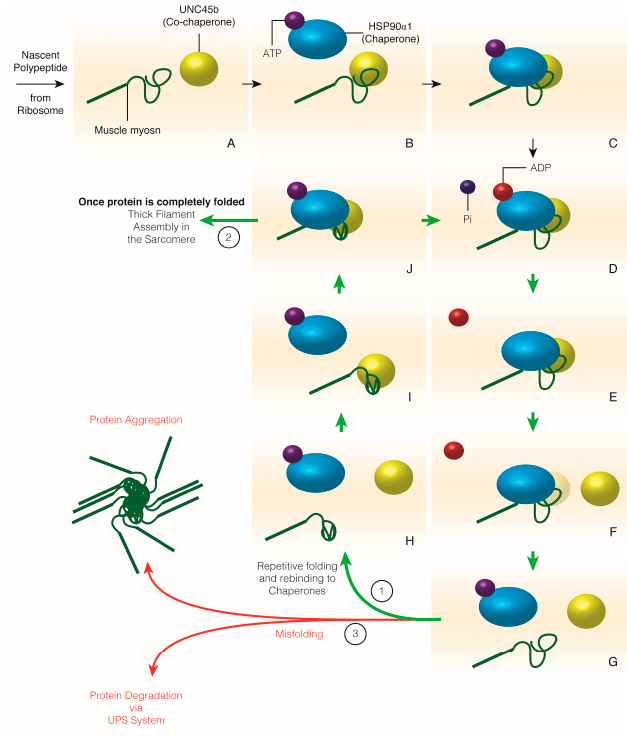
Figure 2. The folding of nascent client proteins by their chaperone and co-chaperones. Exemplifying the folding of the muscle myosin II globular head domain by Hsp90 α 1 and Unc45b as an example of molecular chaperones folding their client proteins. As proteins are synthesized by the ribosome, co-chaperones such as Unc45b can bind to the nascent polypeptide as it emerges from the ribosome ( A , B ). ATP-bound Hsp90 α 1 is recruited to nascent myosin polypeptides by Unc45b ( B , C ). Binding of Hsp90 α 1 causes a conformational change that hydrolyzes ATP to ADP that disassociates from Hsp90 α 1 ( C – E ). Unc45b releases Hsp90 α 1 and myosin, as Hsp90 α 1 rebinds cytoplasmic ATP, which allows the controlled folding of segments of unbound myosin ( F – H ). Hsp90 α 1 and Unc45b repeatedly rebind and fold myosin until it is completely folded ( I , J ; 1 & 2). If myosin is unable to be folded due to missing chaperones or incomplete binding, myosin (or any protein requiring folding) misfolds and can aggregate within the cell or be degraded via the ubiquitin proteasome system (3). Green arrows indicate the sequence of folding events that leads to a correctly folded protein to be incorporated into the sarcomere. Red arrows indicate the outcomes of misfolded proteins. Note that proteins can be discarded from any step of nascent protein folding and aggregate or be